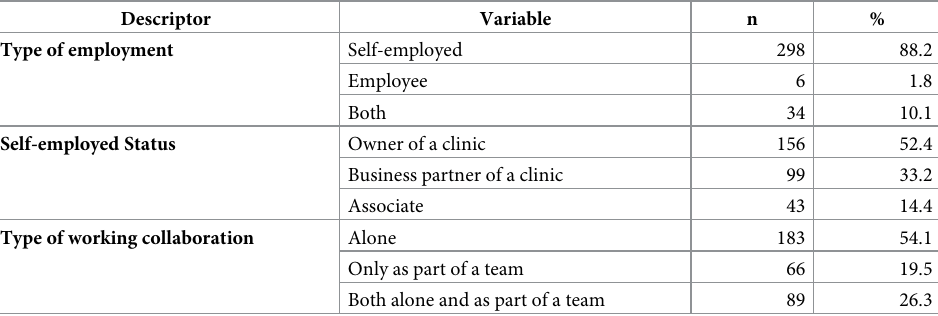
Table 2. Work status of respondents (n =